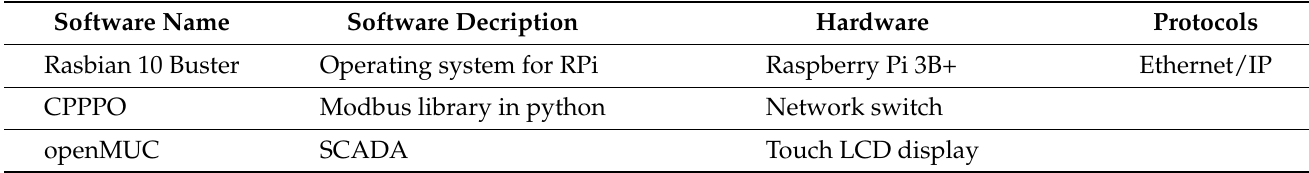
Table 8. Components of the simulated wastewater treatment